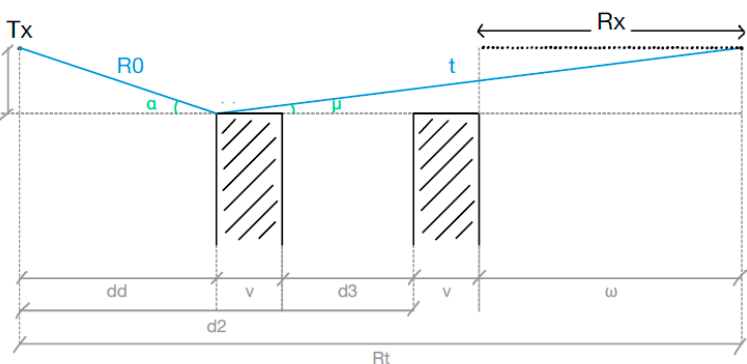
Figure 2. Direct ray contribution of the considered LOS scenario.